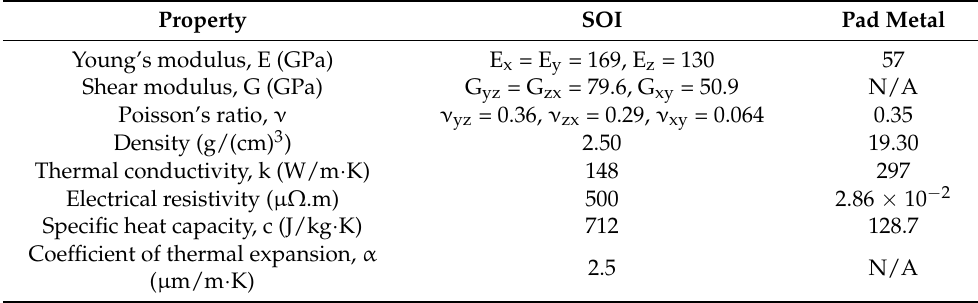
Table 2. Material properties of the SOI and pad metal layers as extracted from [3,14]. The below data was assumed to be at a reference temperature of 22 ◦ C. Note that directions ‘x’ and ‘y’ are in-plane, whereas ‘z’ is